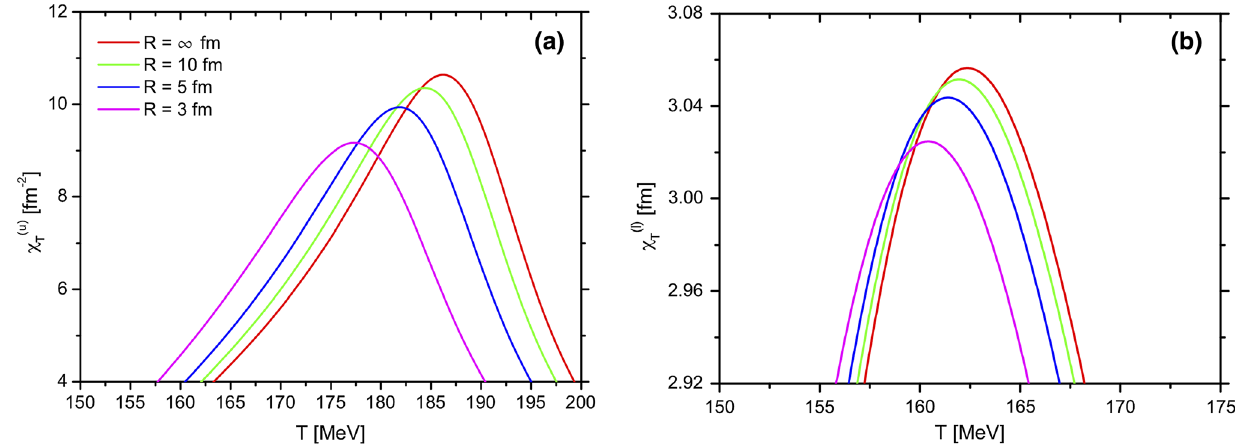
≡ ∂ (cid:4)¯ uu (cid:5) /∂ T and χ l ≡ ∂ l /∂ T as a function of temperature for the polynomial Polyakov loop Fig. 2 We show χ u T T